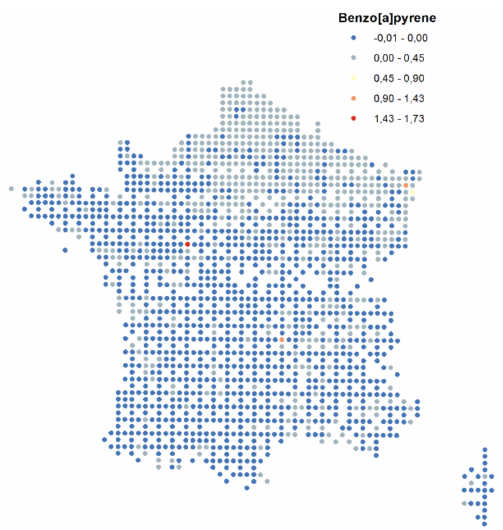
Figure 4. Initial soil data for B[a]P (French soil monitoring network: POP-RMQS); the negative values indicate the values under the detection limit (mg/kg).